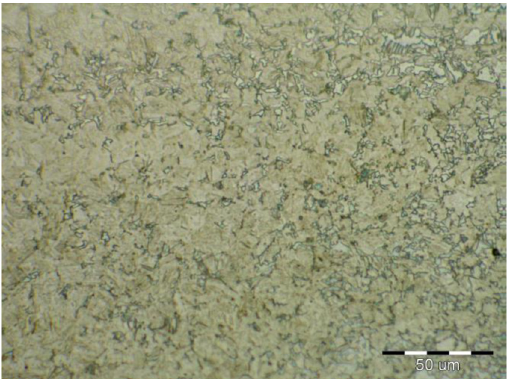
Figure 19. Thermally affected area microstructure formed by martensite and ferrite (TRIP).